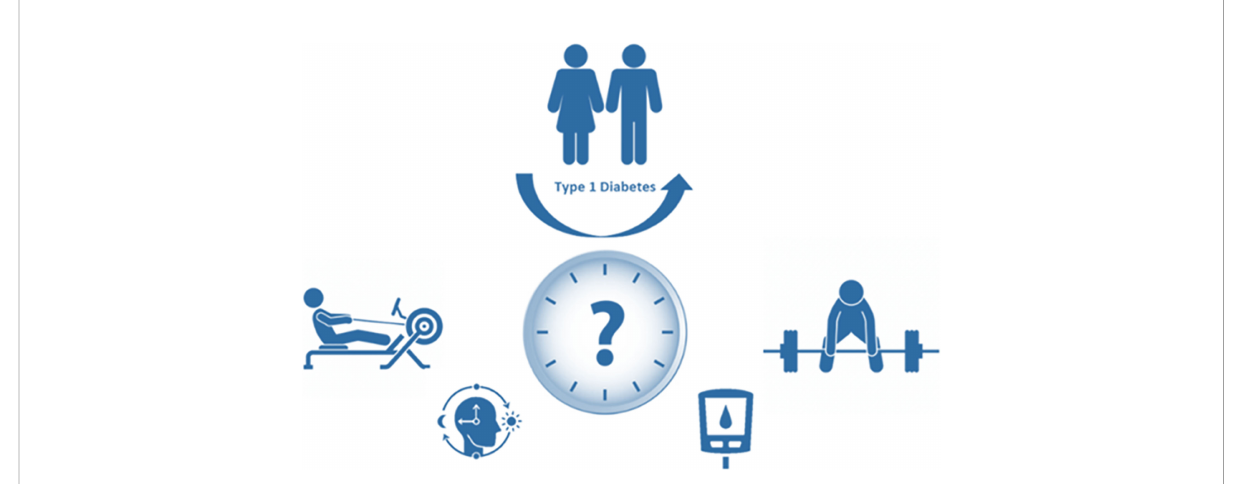
FIGURE 2 Future research in type 1 diabetes should aim to investigate the impact of exercise timing on different exercise modalities in relation to biological factors such as chronotype. Core blood glucose monitoring (CGM) is a metabolic predictor of speci fi c